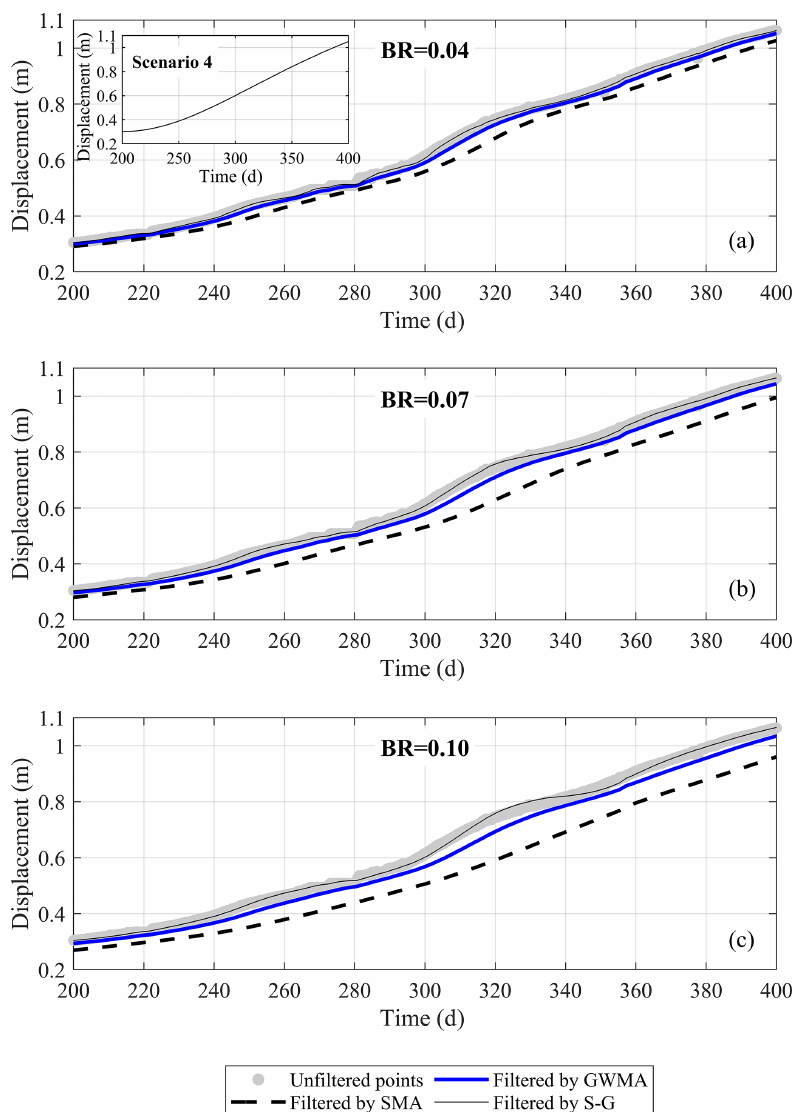
Figure 16. Unfiltered displacement of Geocube 46 data vs. time and data filtered by SMA, GWMA, and S-G for bandwidth ratios (BRs) of (a) 0.04, (b) 0.07, and (c)